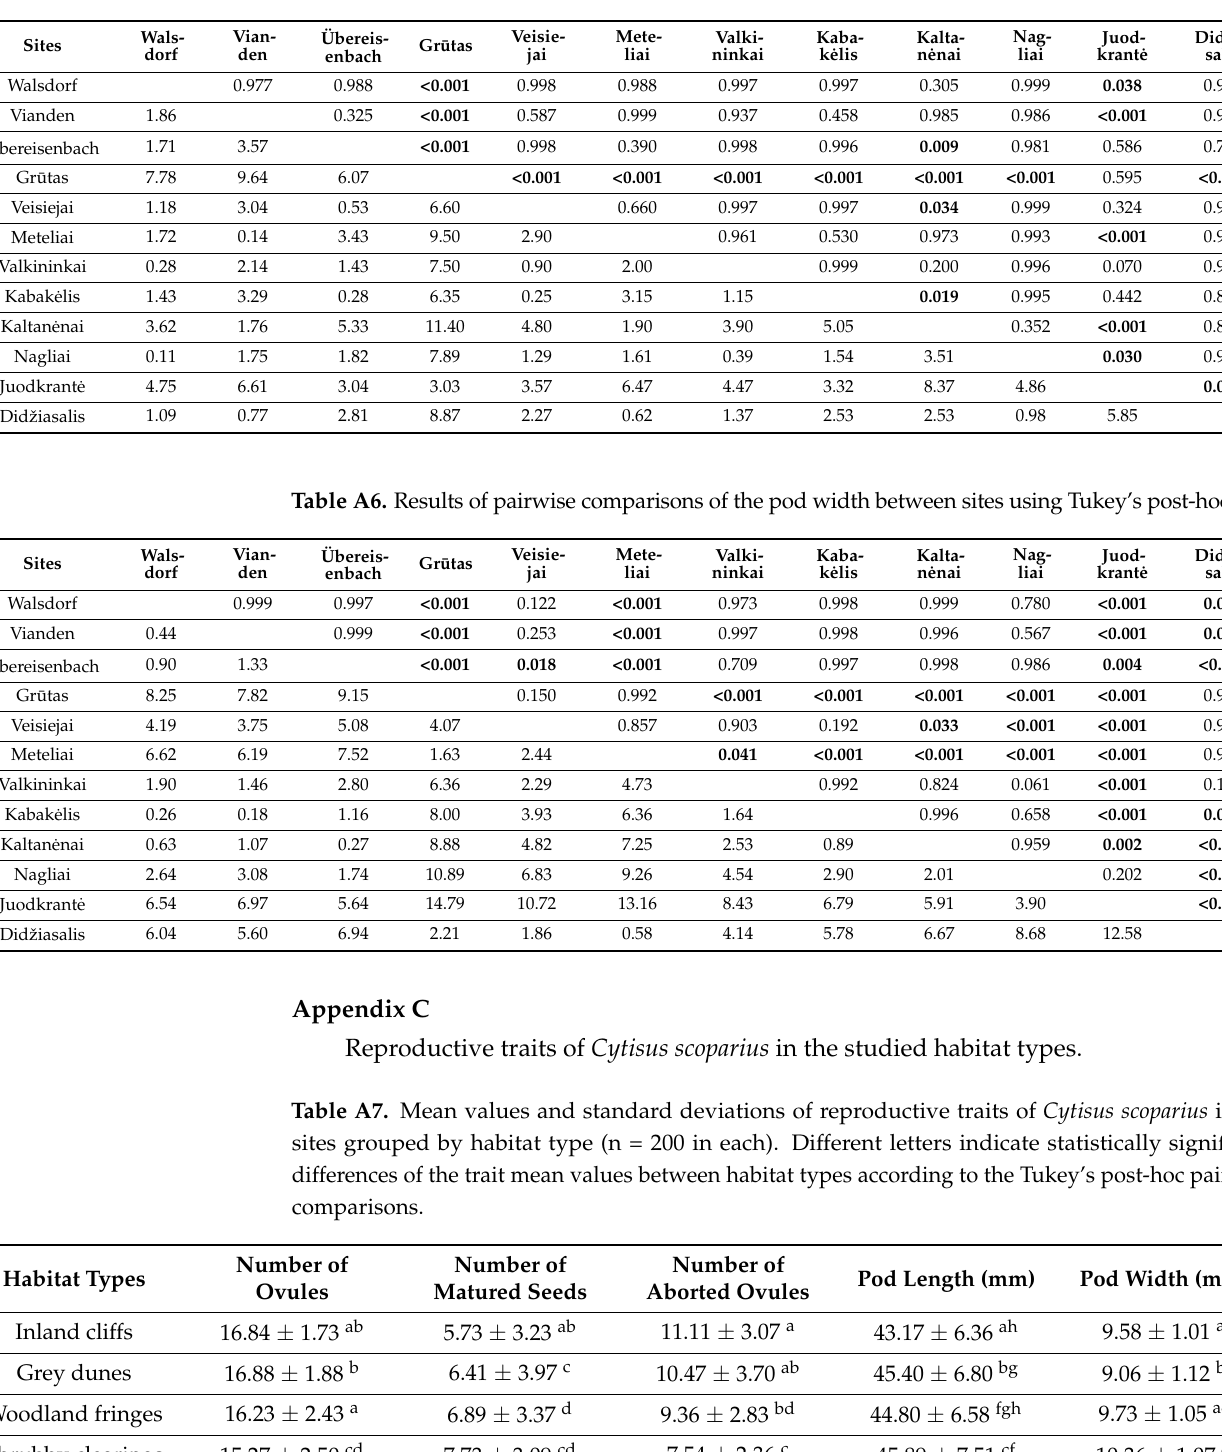
Table A5. Results of pairwise comparisons of the pod length between sites using Tukey’s post-hoc test.